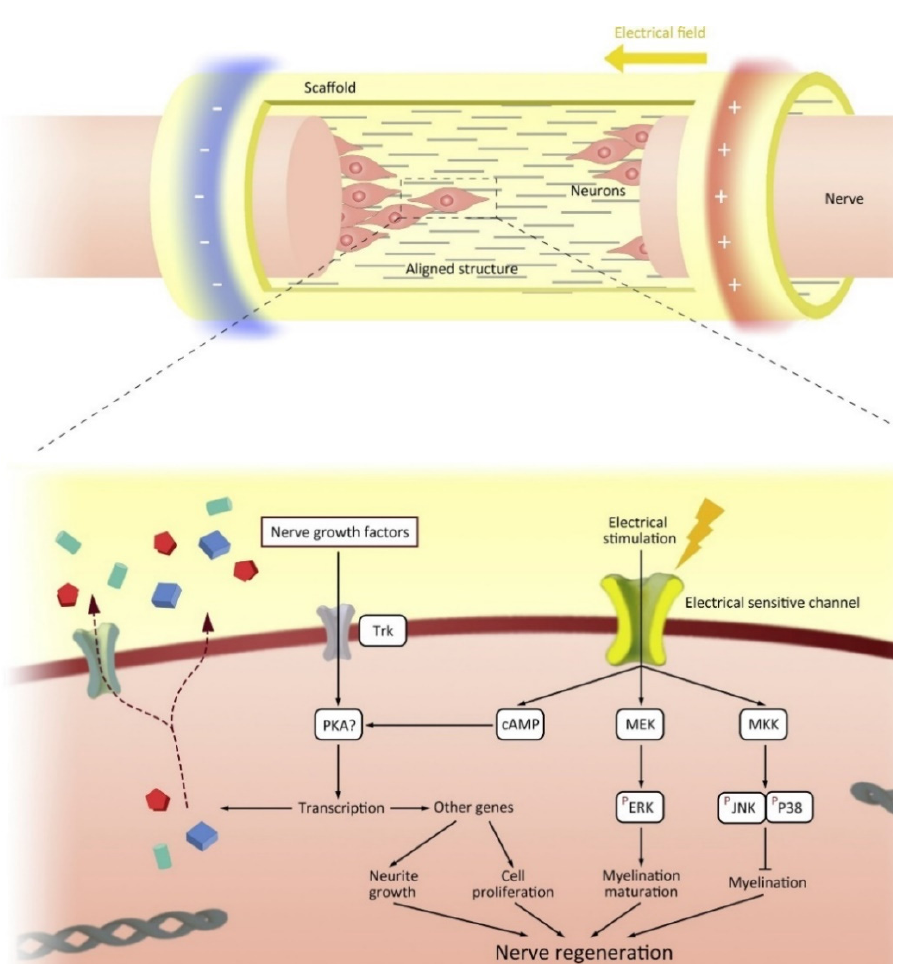
Figure 8. The mechanism of how electroconductive materials trigger the nerve regeneration through intracellular signalling. Reproduced with permission from [136]. Copyright (2020) Elsevier.